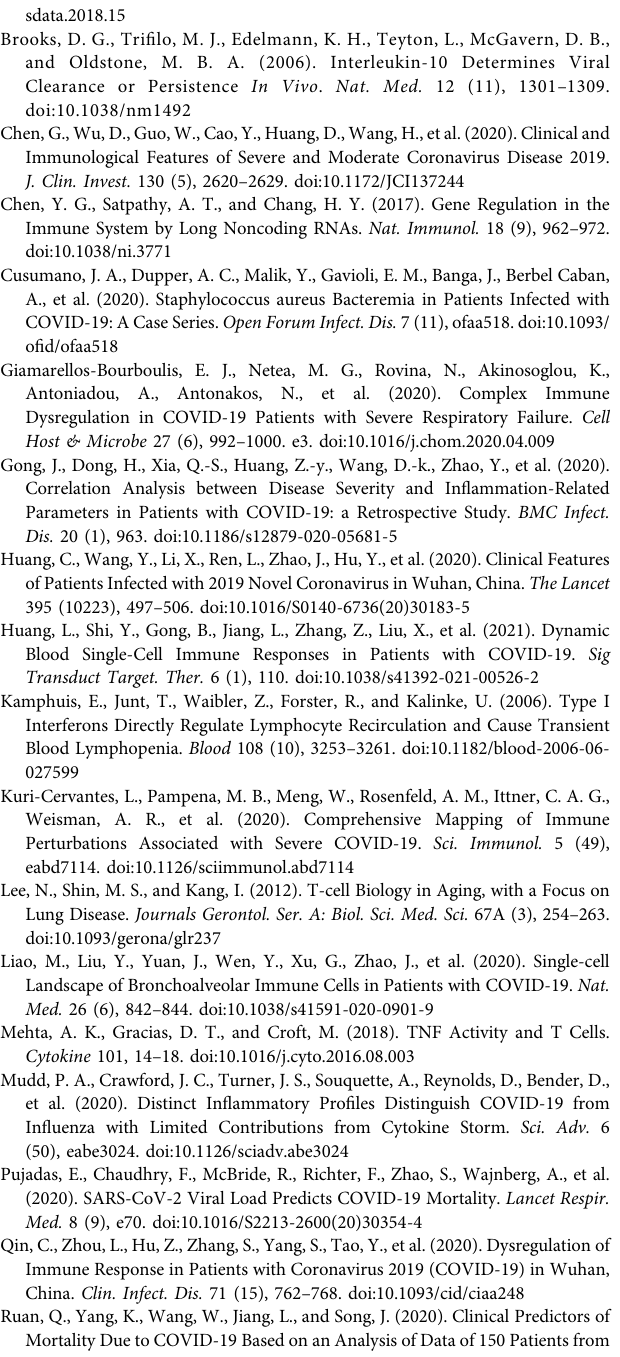
correlation heatmap between 4 lncRNAs with cytokines and chemokines. p -values generated by one-way ANOVA with multiple comparisons by Tukey ’ s test. ns: non- signi fi cant; *p < 0.05; **p < 0.01, ***p < 0.001, ****p <